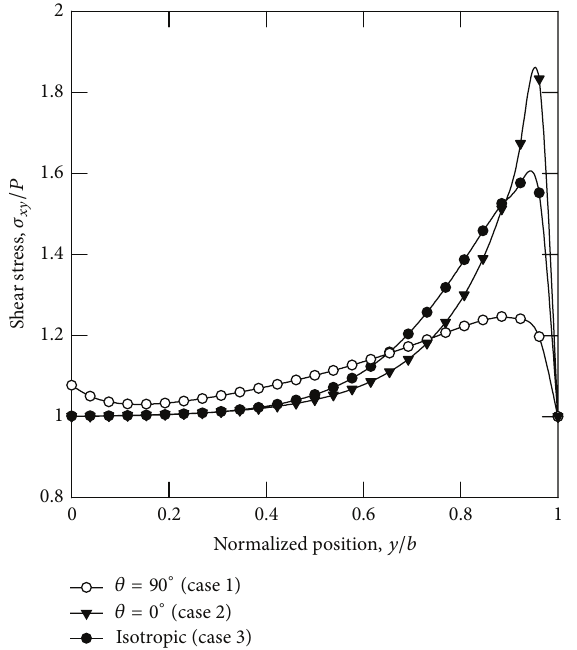
Figure 7: Effect of fiber orientation and material isotropy on the normalized shear stress component at the section 𝑥/𝑎 = 0 of the panel.